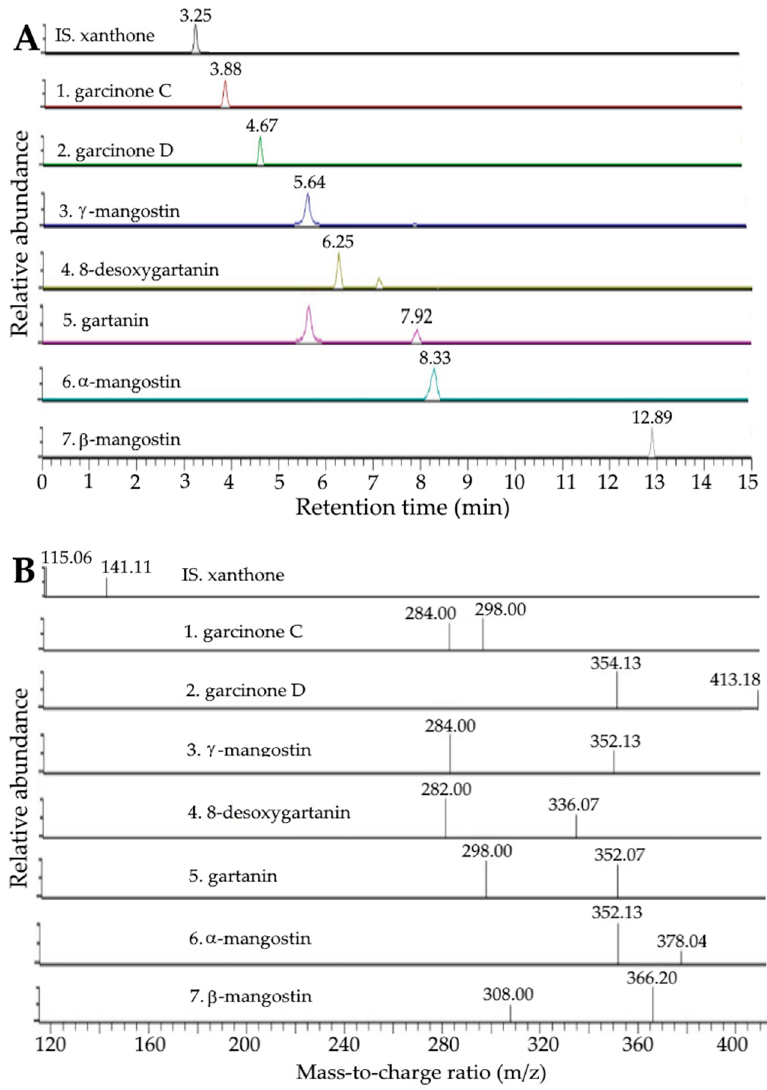
Figure 2. UPLC-MS/MS chromatograms of xanthone extract containing internal standard (xanthone) as detected by SRM mode ( A ) and their corresponding tandem mass spectra ( B ).